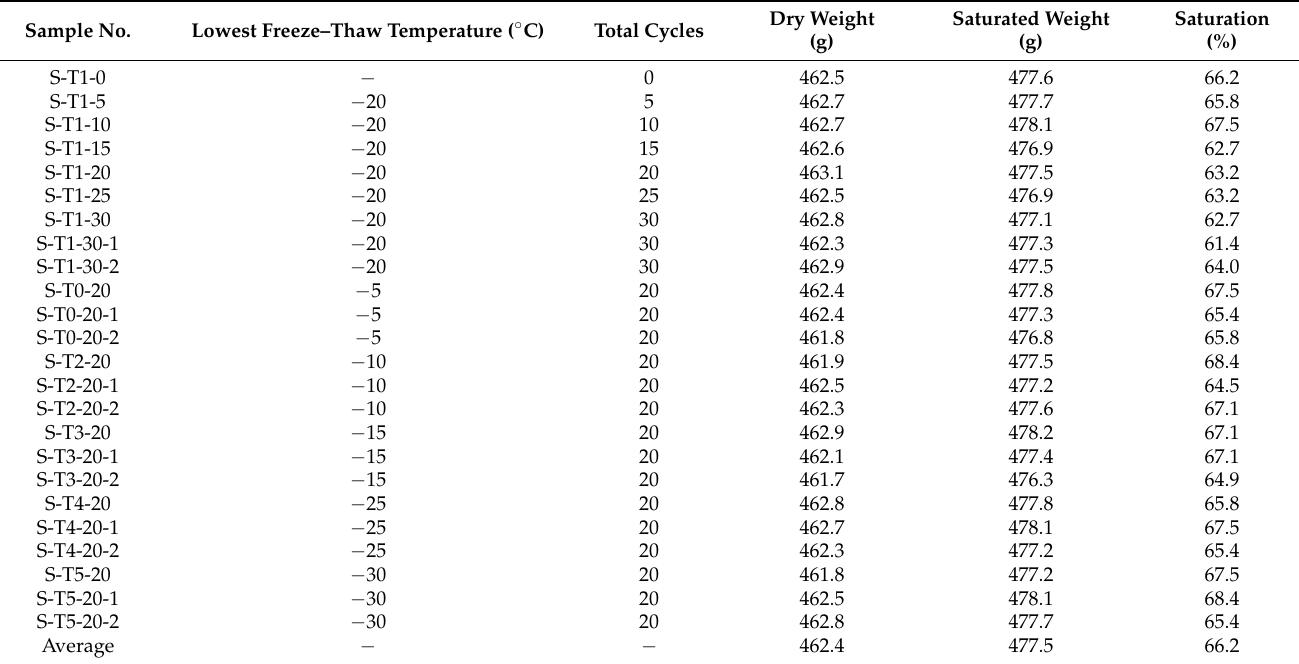
Table 1. Freeze–thaw cycles and temperature